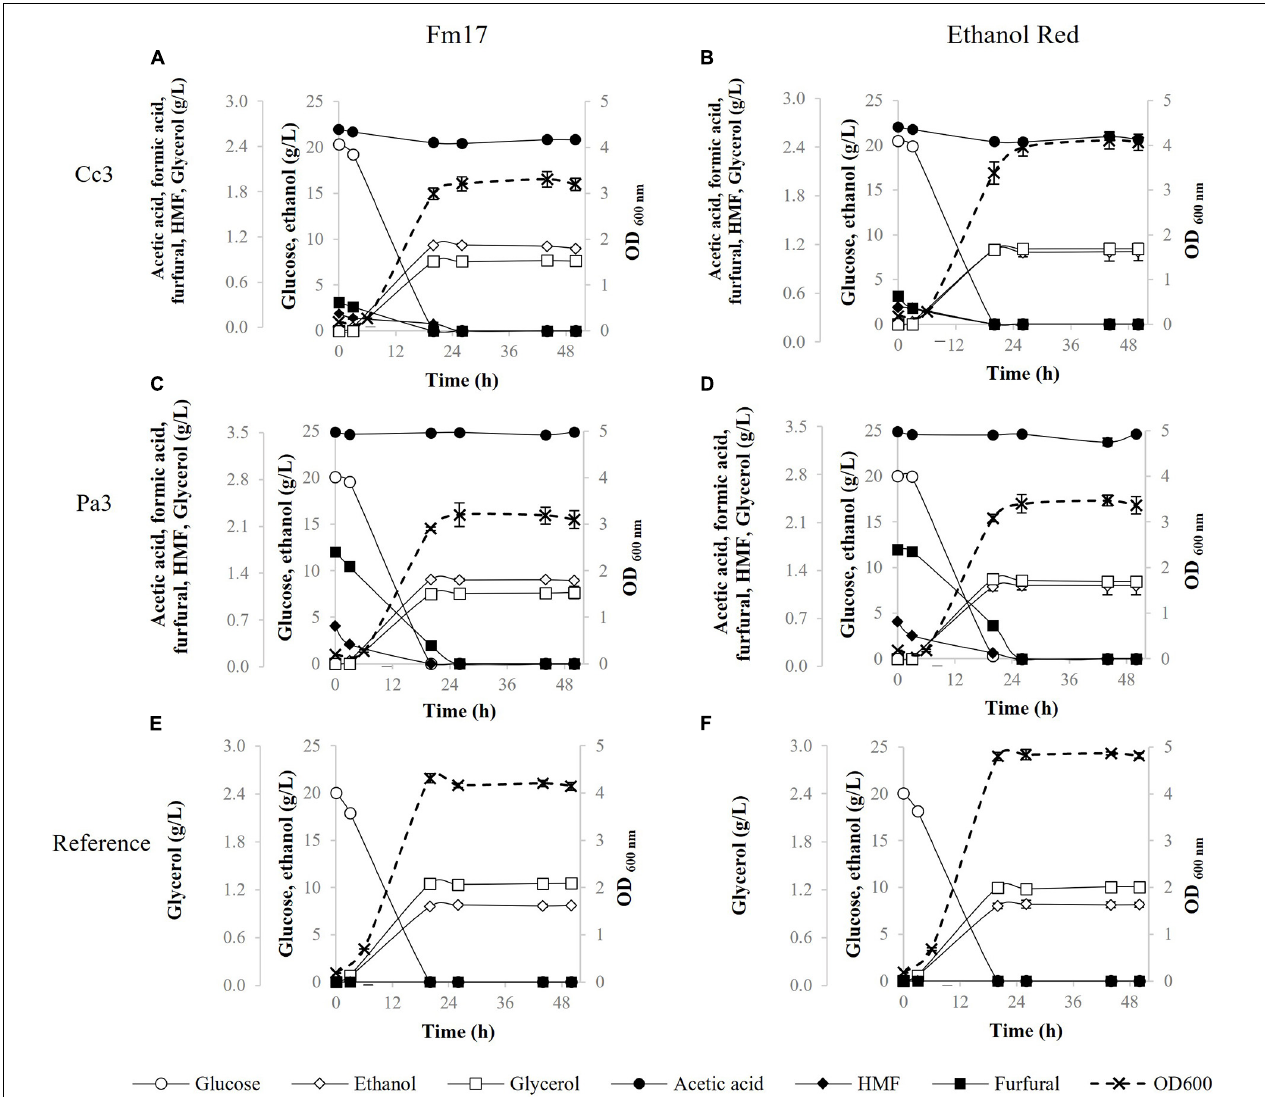
FIGURE 1 | Fermentation performances in the presence of pre-hydrolysate Cc3 from Cynara cardunculus and Pa3 from Phragmites australis , supplemented with YNB containing 20 g/L of glucose, by Saccharomyces cerevisiae Fm17 (A,C) and Ethanol Red (B,D) . S. cerevisiae Fm17 (E) and Ethanol Red (F) were inoculated also in the reference broth (YNB containing 20 g/L of glucose without any pre-hydrolysate). When necessary, acidity of the medium was adjusted to pH 5.0 with NaOH. The experiment was conducted in triplicate. Error bars correspond to the standard deviation of the